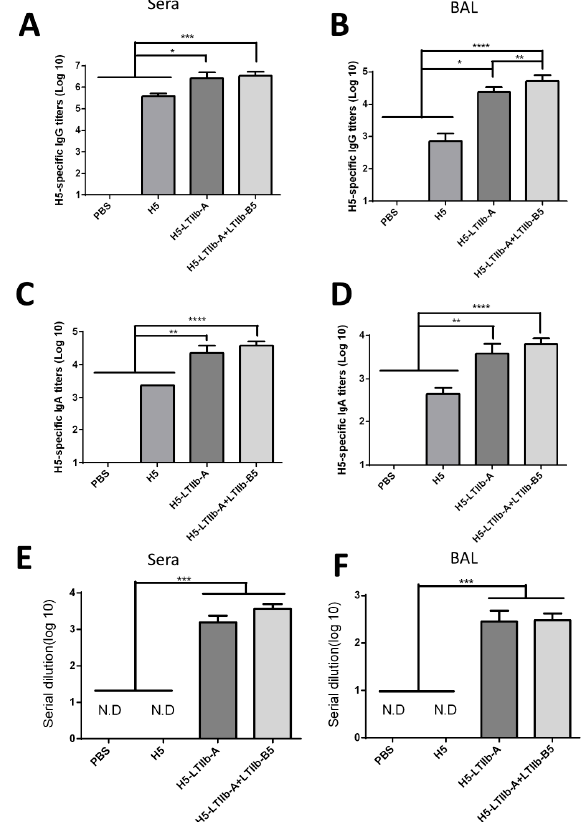
Figure 3. Antibody responses elicited by intranasal immunizations with H5-LTIIb-A fusion protein. Groups of BALB/c mice were immunized with phosphate buffered saline (PBS), H5 protein (H5), H5-LTIIb-A fusion protein (H5-LTIIb-A), or the combination of H5-LTIIb-A fusion protein and another LTIIb-B5 subunit protein (H5-LTIIb-A+LTIIb-B5). The antibody titers were measured for anti-H5 IgG, IgA, and neutralizing antibodies in serum ( A,C,E ) and BALF ( B,D,F ).